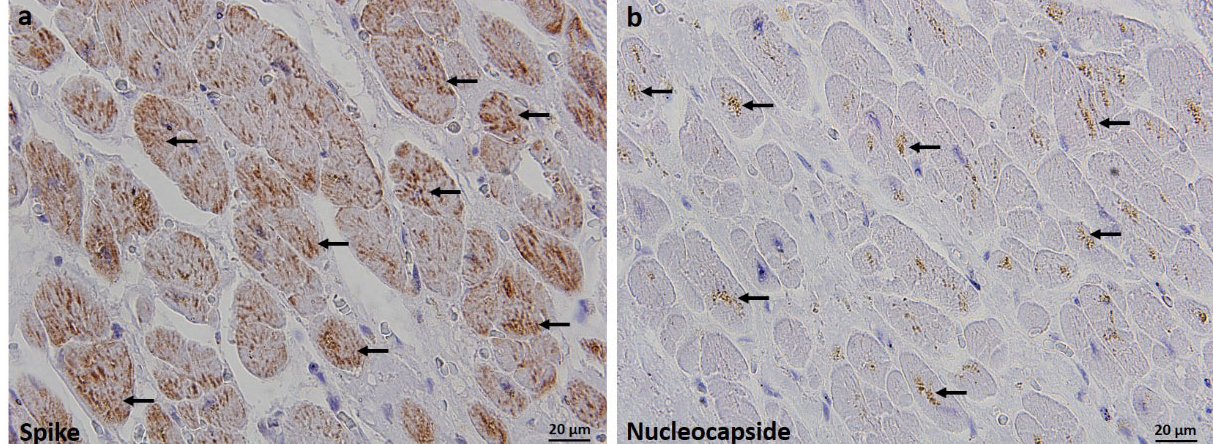
Figure 1. Immunohistochemical detection of severe acute respiratory syndrome coronavirus 2 (SARS-CoV-2) spike protein ( a ) and nucleocapsid protein ( b ) in the cardiac atrioventricular node (AV-node) obtained from a patient who died from COVID-19 and had an abnormal heart rhythm prior to death. Spike protein expression was diffusely present in the cytoplasm of conducting cardiomyocytes, resembling endoplasmic reticulum arrangement and rendering a “tigroid” appearance, ( a ) shown with arrows. Nucleocapsid immunopositivity was less abundant and showed scattered punctiform staining patterns, frequently forming juxtanuclear aggregates, shown with ( b ) arrows. Staining was performed using the rabbit anti-SARS-CoV-2 spike glycoprotein antibody (Abcam, Cambridge, UK, ab272504; dilution 1:4000) and mouse anti-SARS-CoV-2 nucleocapsid protein antibody (Cell Signaling Technology, Danvers, MA, USA, clone E8R1L; dilution 1:200). Immunoreactions were visualized by DAKO EnVision+System (DAKO Cytomation, Santa Clara, CA, USA). Magnification × 600. Tissue was obtained from the base of the atrial septum in the Koch triangle. Prior to death, the patient had atrial tachycardia, left posterior fascicular block (LPFB), and right bundle branch block (RBBB).